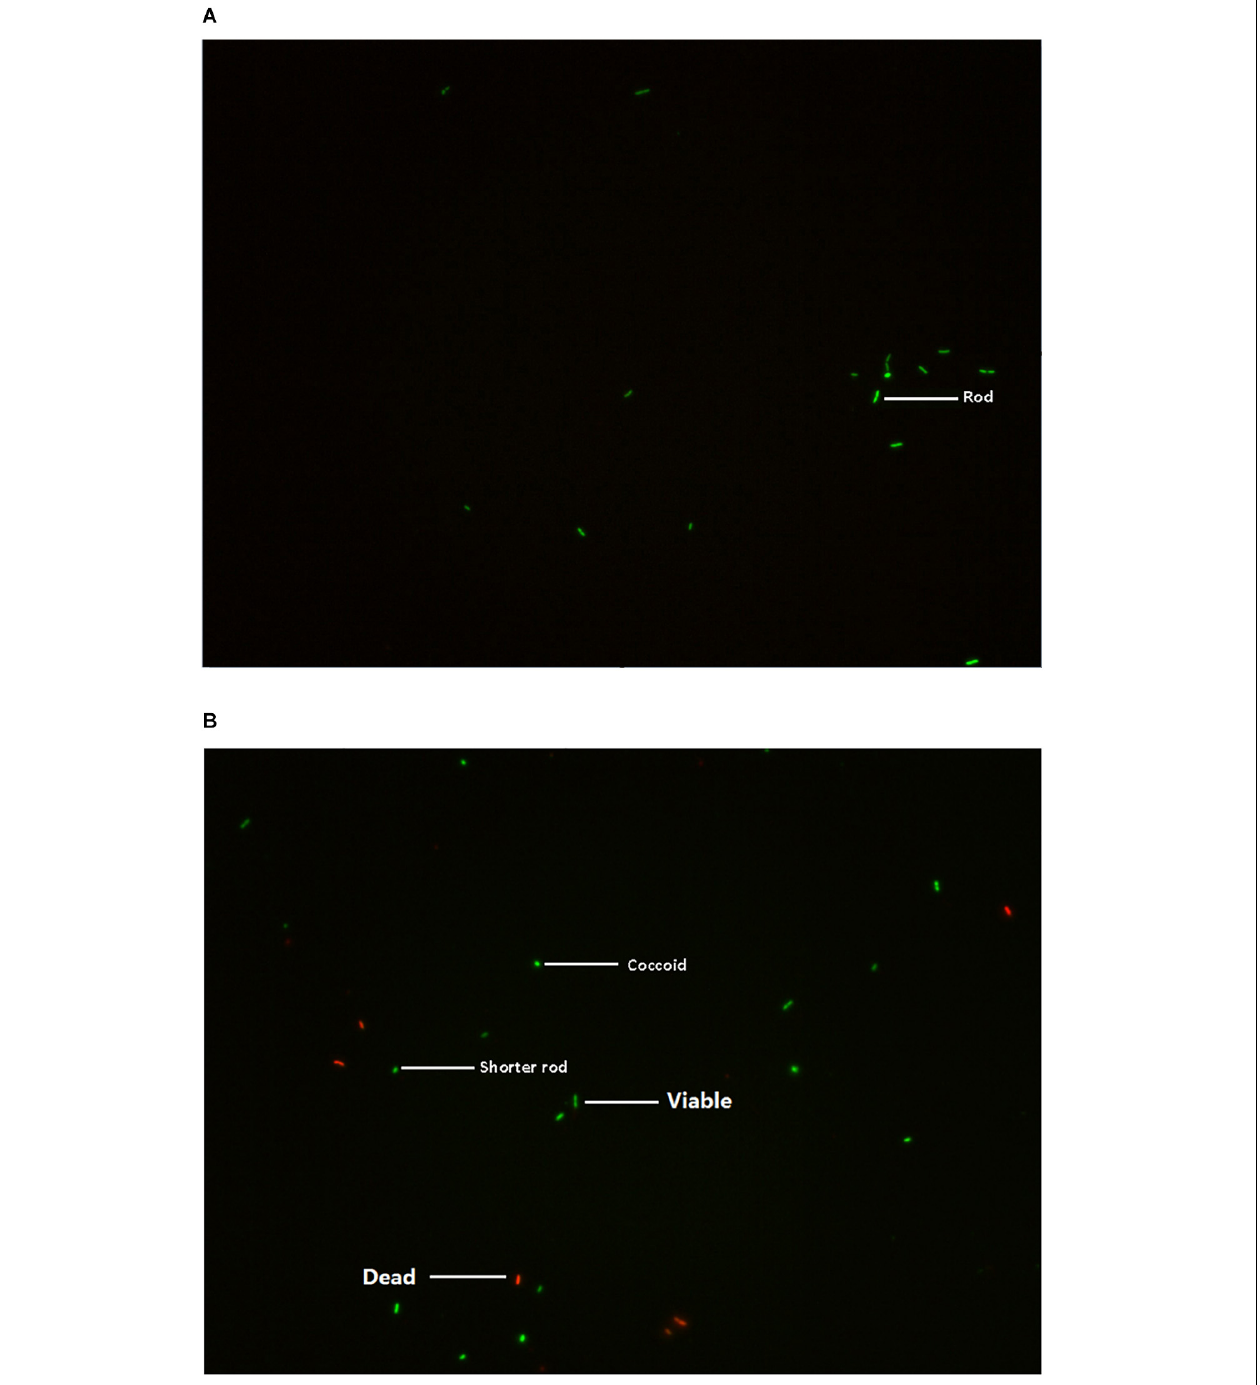
FIGURE 1 | Characterization of E. coli O157 in normal viable (A) and VBNC state (B) under fluorescence microscopy.